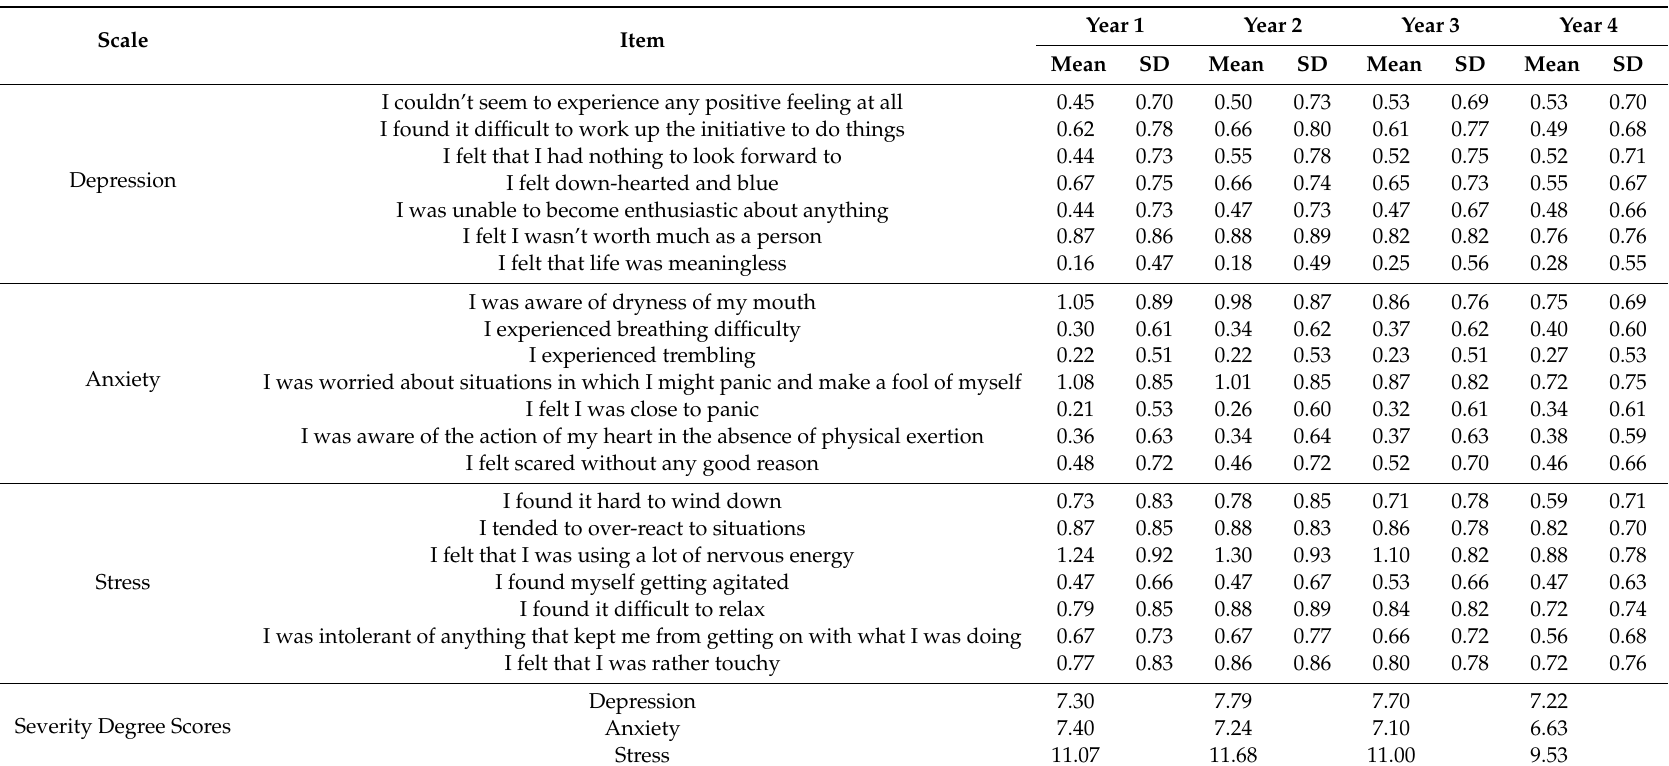
Table 3. Descriptive statistics of each item in the Depression Anxiety Stress Scales-21 (DASS-21) across years.